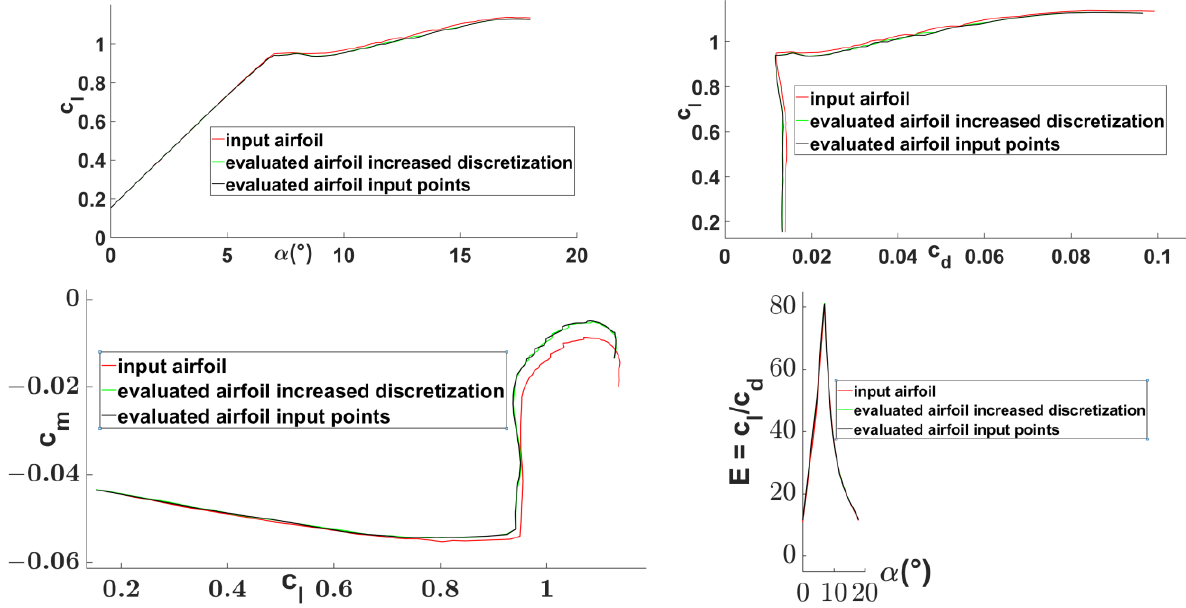
Figure 25. NREL ’ s 809 input airfoil, evaluated airfoil, evaluated airfoil increased discretization (140 points) 𝑐 𝑙 (𝛼), 𝑐 𝑙 (𝑐 𝑑 ) 𝑐 𝑚 (𝑐 𝑙 ), 𝐸(𝛼) = 𝑐 𝑙 (𝛼) 𝑐 𝑑 (𝛼)⁄ comparison.